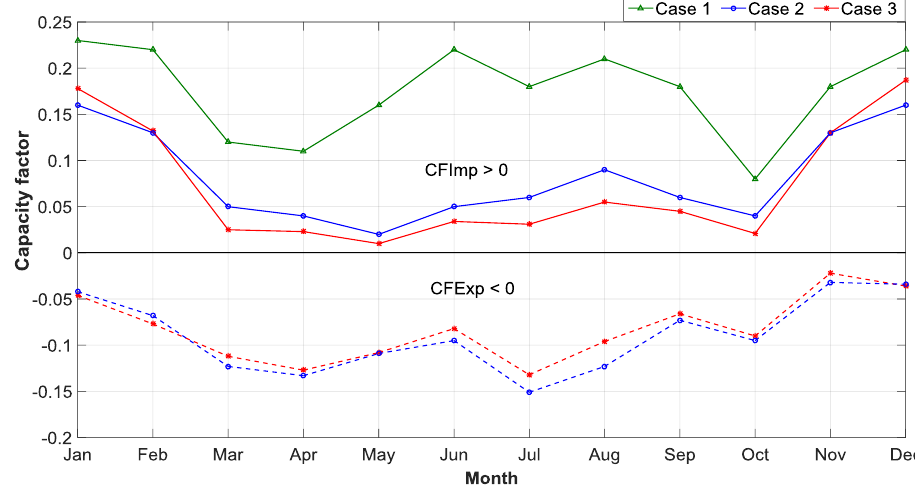
Figure 13. Yearly capacity factors in the investigated cases.